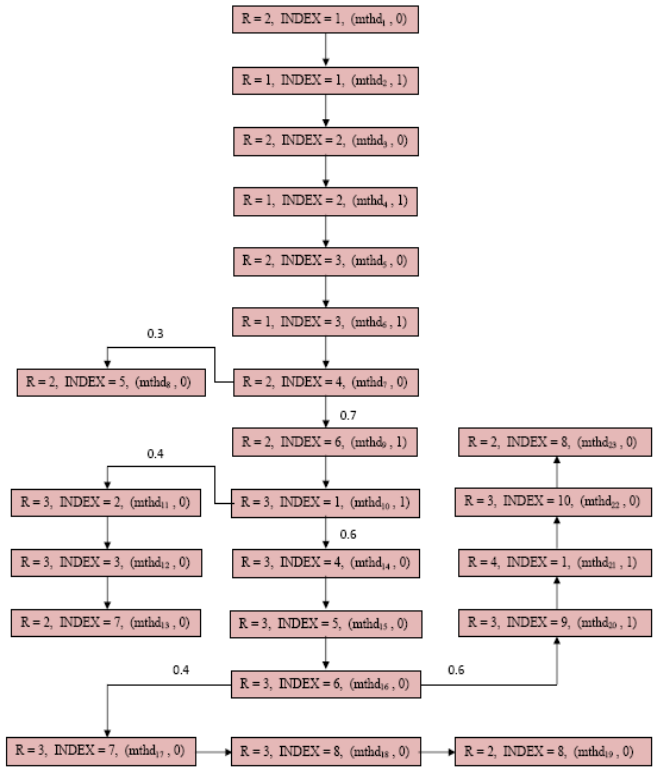
Fig. 8. The middle graph structure (the interface between the semi-formal model and the formal model) In this level, we extract the label PAdemand value in each reference to the resource from the sequence diagram from the top to the bottom and we will write them per each resource. Table (6) shows these values pertaining to each resource.